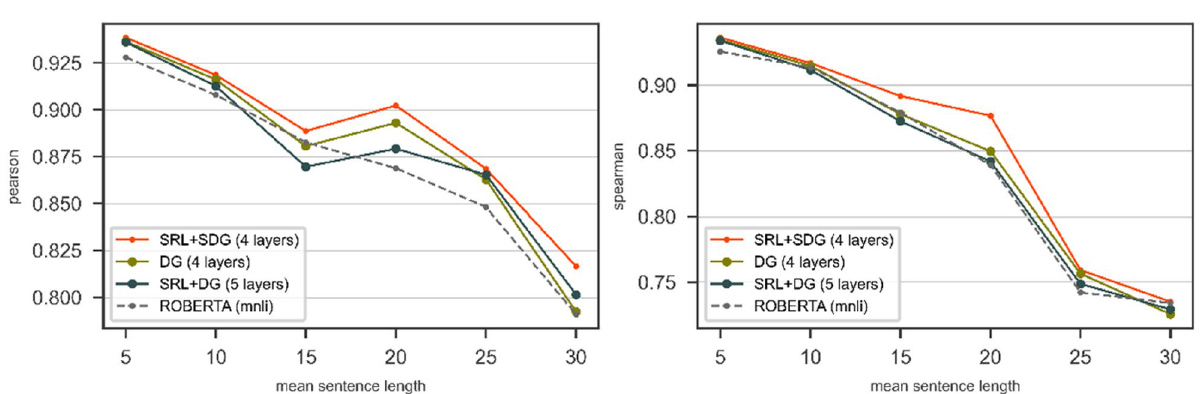
Figure 8. The results of RoBERTa and the DGNN on top of the RoBERTa over SRL + SDG, SRL + DG, and DG graphs on STS2017/Test in terms of Pearson (left) and Spearman (right). The pair of sentences with mean length is categorized in the window [ − 2, 2]